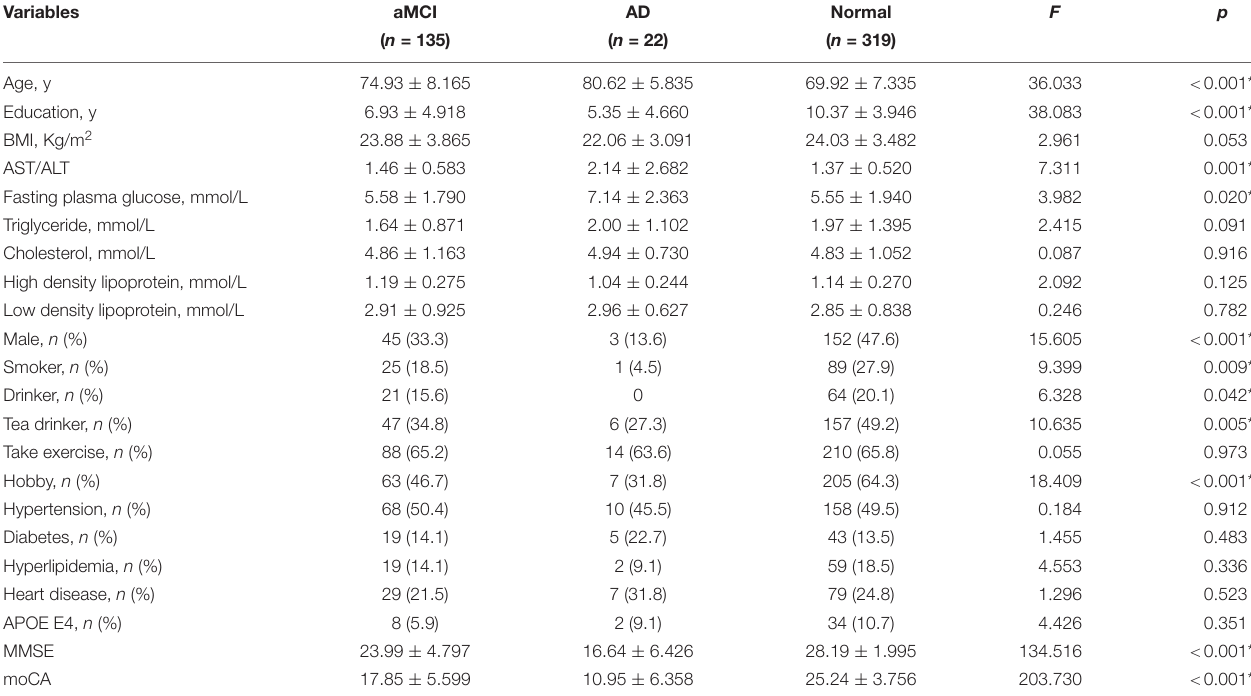
TABLE 1 | Comparison of general demographic data among three groups.